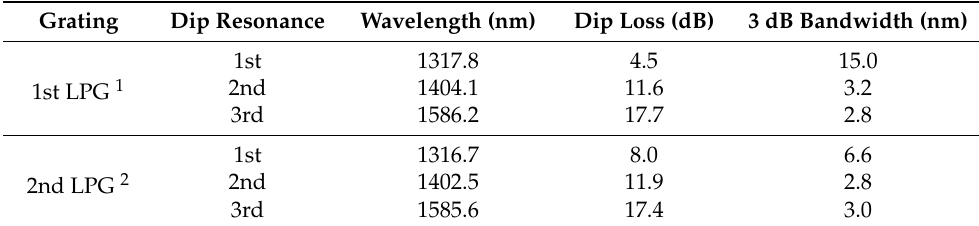
Table 1. Comparison of the grating spectral parameters for two 690 µm period LPGs written in the same conditions and with ~38 mm length.